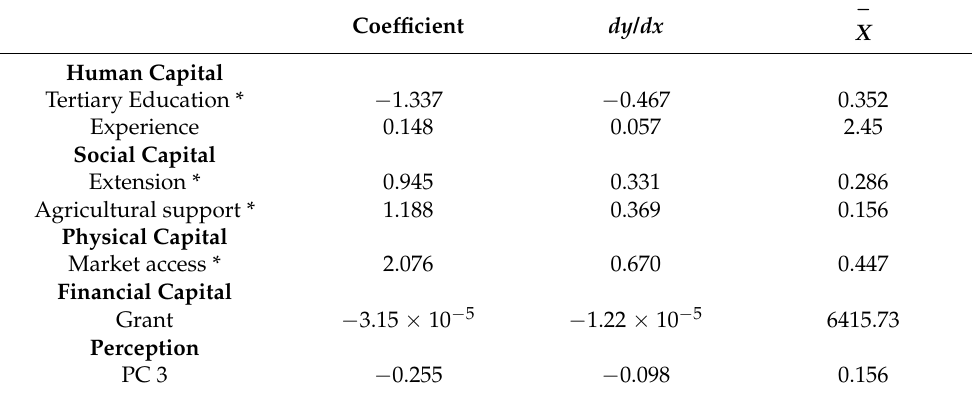
Table 5. Marginal effect of the significant